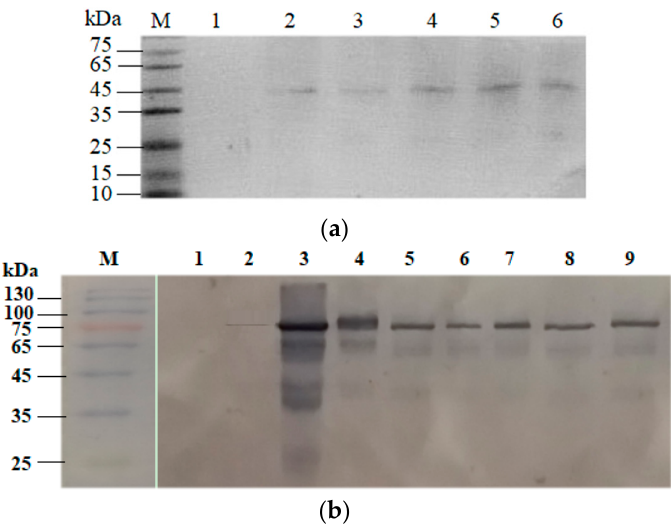
Figure 3. Western blotting analysis of immobilization of Bs β –Gal on the spores via Coh–Doc interaction. ( a ) Expression of CotG–Coh was analyzed using anti–FLAG as the primary antibody. M, standard protein marker; 1, CotG; 2, CotG– Ct Coh-I; 3, CotG– Ct Coh-II; 4, CotG– Ccs Coh-I; 5, CotG– Ccm Coh-I; 6, CotG– Rf Coh-III. ( b ) Expression of CotG–Coh/ Bs β –Gal-Doc was detected using anti–